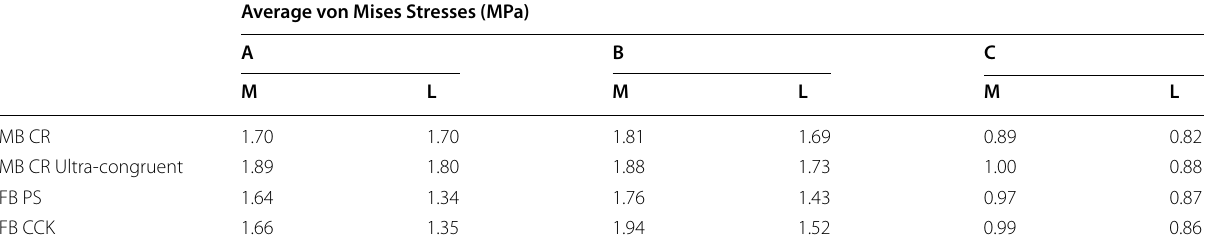
Table 3 Average medial and lateral von Mises stresses (MPa) in the proximal region of the cortical tibial